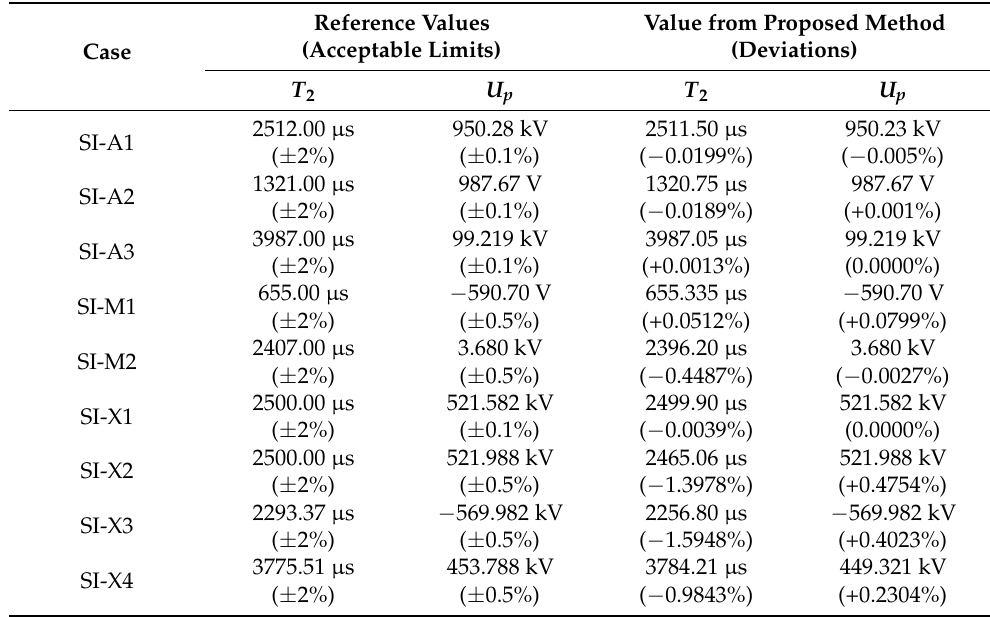
Table 2. Reference and calculated values, acceptable limits, and deviations of T 2 and U p .